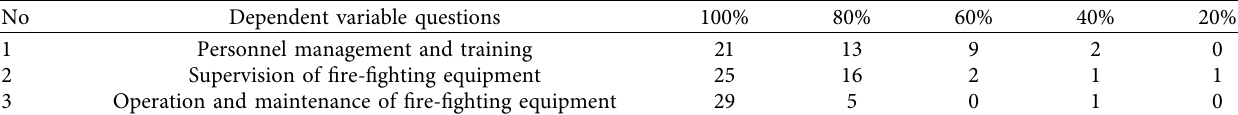
Table 15: Questionnaire feedback of AI fre-fghting facility.